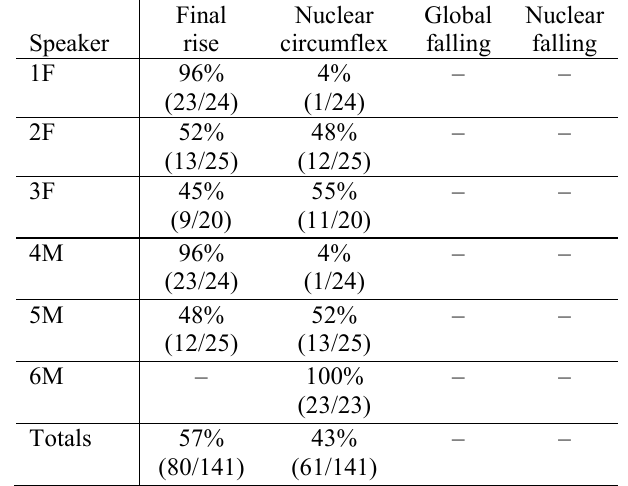
Table 2. Person identification task contour